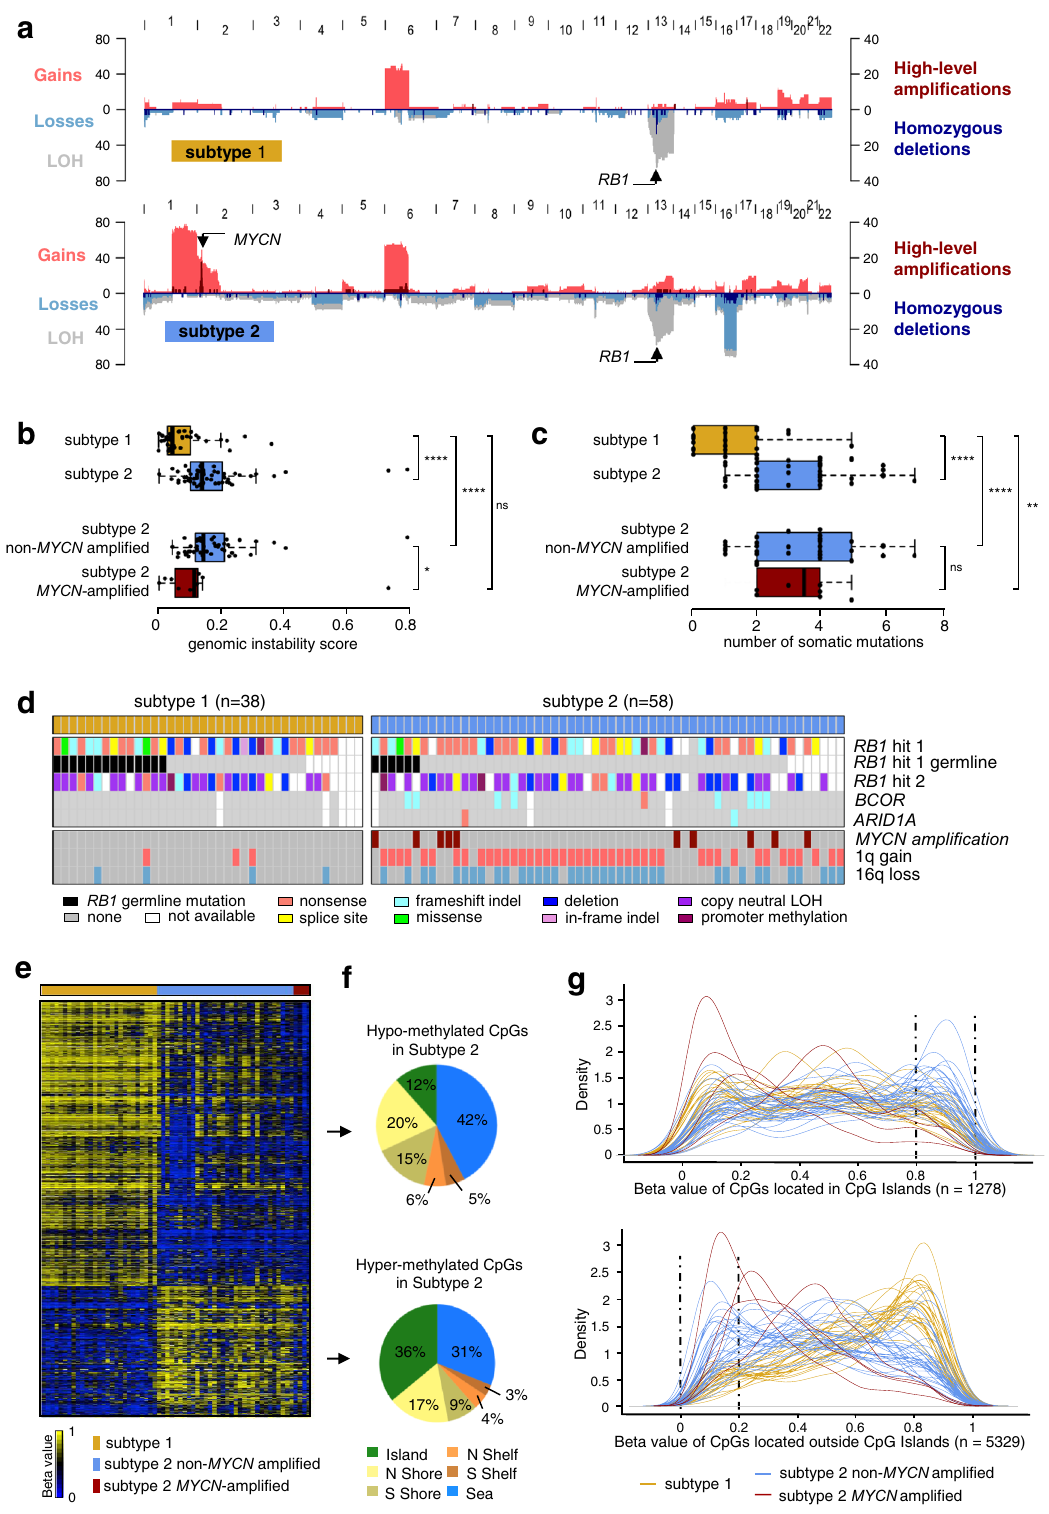
different stages of cone differentiation. Retinal organoids are three-dimensional structures derived from human induced plur- ipotent stem (iPS) cells that recapitulate the spatial and temporal differentiation of the retina providing powerful in vitro models of human retinal development 48,49 . We measured the level of expression of early and late cone markers in retinal organoids at various time points (d35, d49, d56, d84, d112, d175) after the